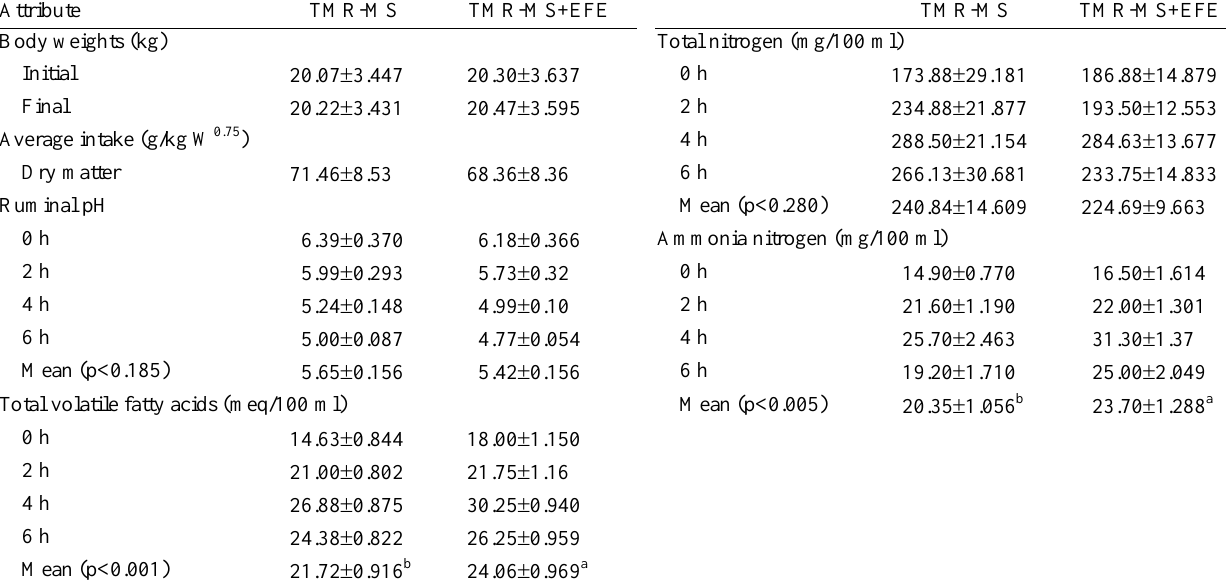
Table 4. Rumen fermentation pattern in lambs fed maize stover based TMR supplemented with EFE Attribute